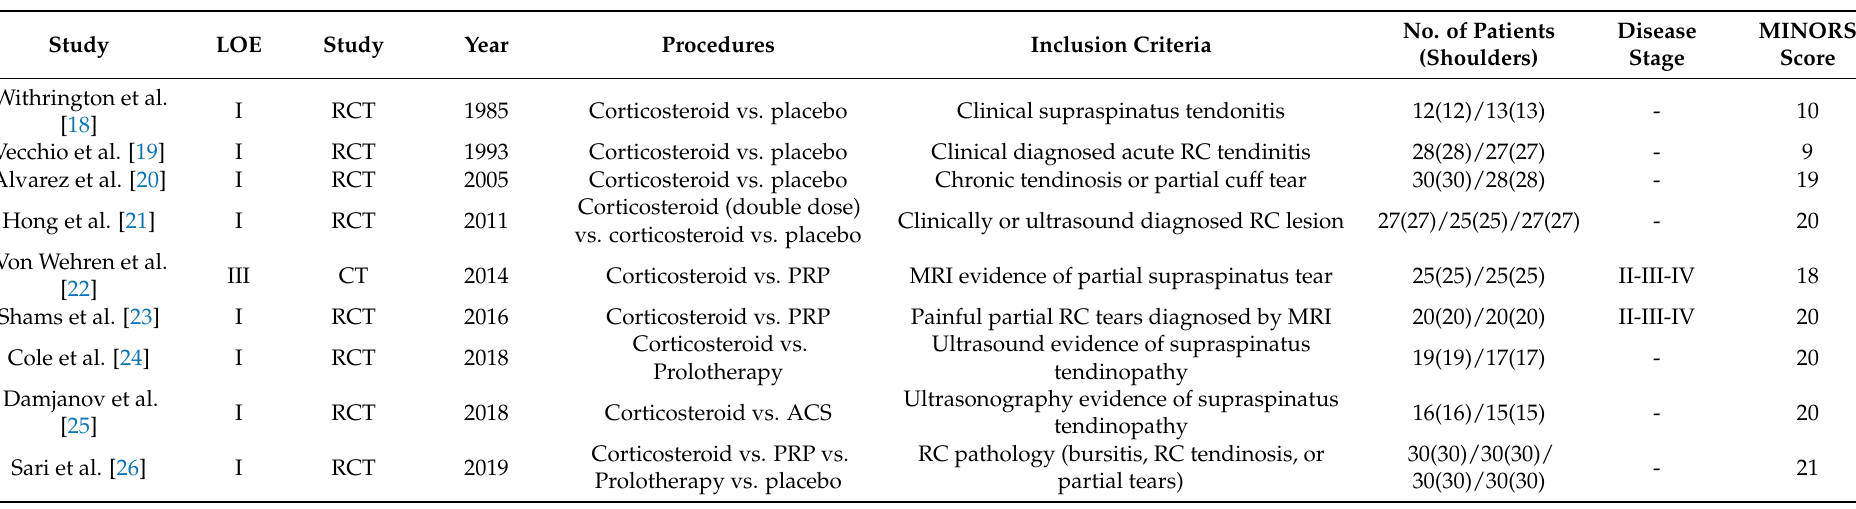
Table 2. Main outcomes. Abbreviations: ASES, American Shoulder and Elbow Surgeons Shoulder Score; DASH, Disabilities of the Arm, Shoulder and Hand Score; ROM, range of motion; Rx, treatment; SDQ, Shoulder Disability Questionnaire; SST, Simple Shoulder Test; VAS, visual analog scale; WORC, Western Ontario Rotator Cuff Index; CS, Constant Shoulder Score; wk, weeks. Study Follow-Up (wk) Outcome Measure Procedures/Rx Dose Withrington et al. [18] Steroid vs. Placebo Steroid vs. Placebo Steroid vs. Placebo Steroid (double dose) vs. Steroid vs. Placebo Steroid vs. PRP Steroid vs. PRP Pain calculated with a 5 pt Likert scale, ROM Steroid vs. Prolotherapy Steroid vs. PRP Steroid vs. PRP vs. Prolotherapy vs.